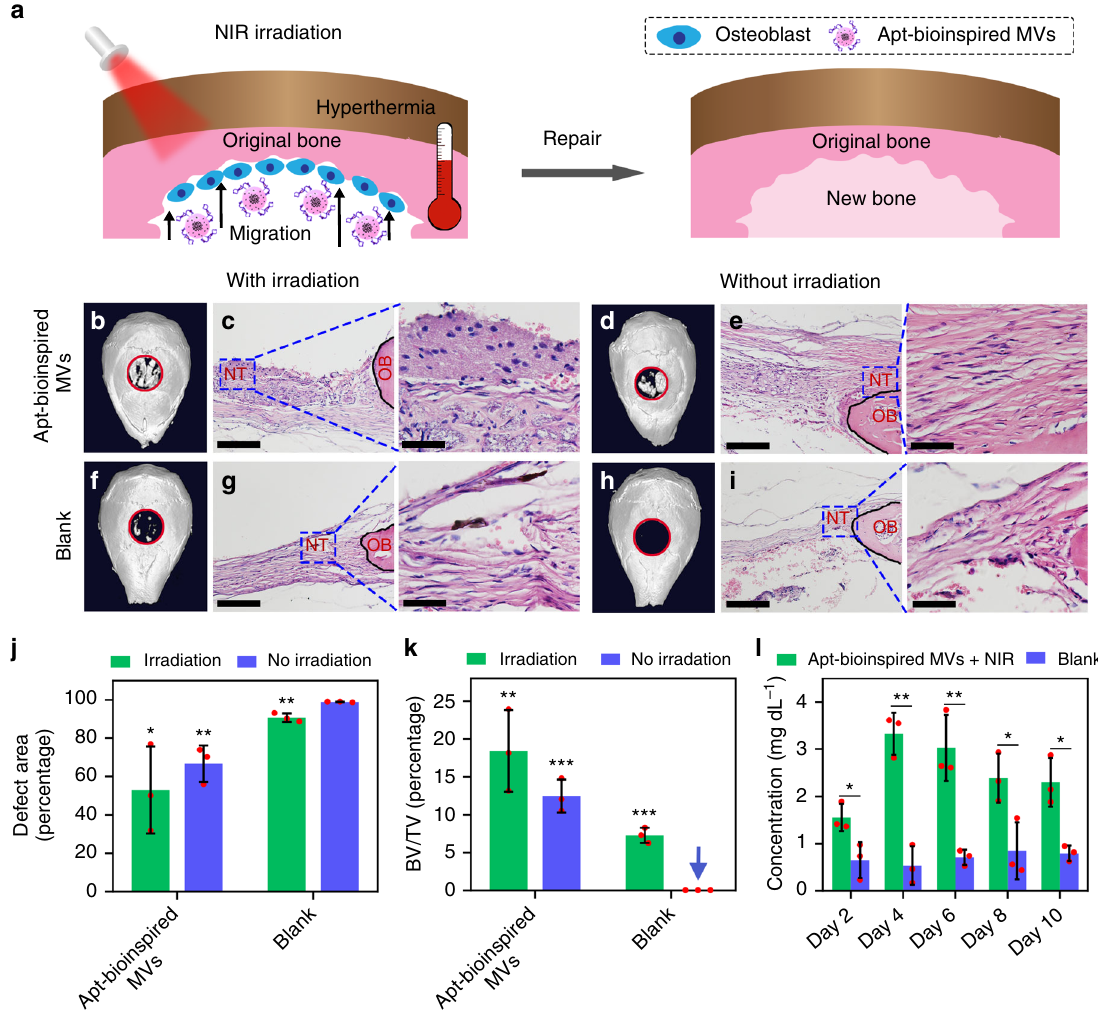
Fig. 6 In vivo bone defect repair with the Apt-bioinspired MVs. a Schematic illustration of bone repair with Apt-bioinspired MVs. b μ -CT reconstruction of the bone defect and c histomorphological analysis of the tissue after treatment with Apt-bioinspired MVs and NIR irradiation. d μ -CT reconstruction of the bone defect and e histomorphological analysis of the tissue after treatment with Apt-bioinspired MVs. f μ -CT reconstruction of the bone defect and g histomorphological analysis of the tissue after treatment with PBS and NIR irradiation. h μ -CT reconstruction of the bone defect and i histomorphological analysis of the tissue after treatment with PBS. The red rings represent the bone defects. The black solid lines denote the origin bone margins. NT represents newly formed tissue, and OB represents origin bone. j Quanti fi cation of defect area and k quanti fi cation of bone volume fraction (BV/TV, bone volume/tissue volume). l Concentration variation of phosphate ions over 10 days in the bone defect region of mice treated with Apt-bioinspired MVs under NIR irradiation and PBS, respectively. Scale bars in c , g , e , f and the corresponding insets are 100 and 50 μ m, respectively. Data are means± s.d. ( n =